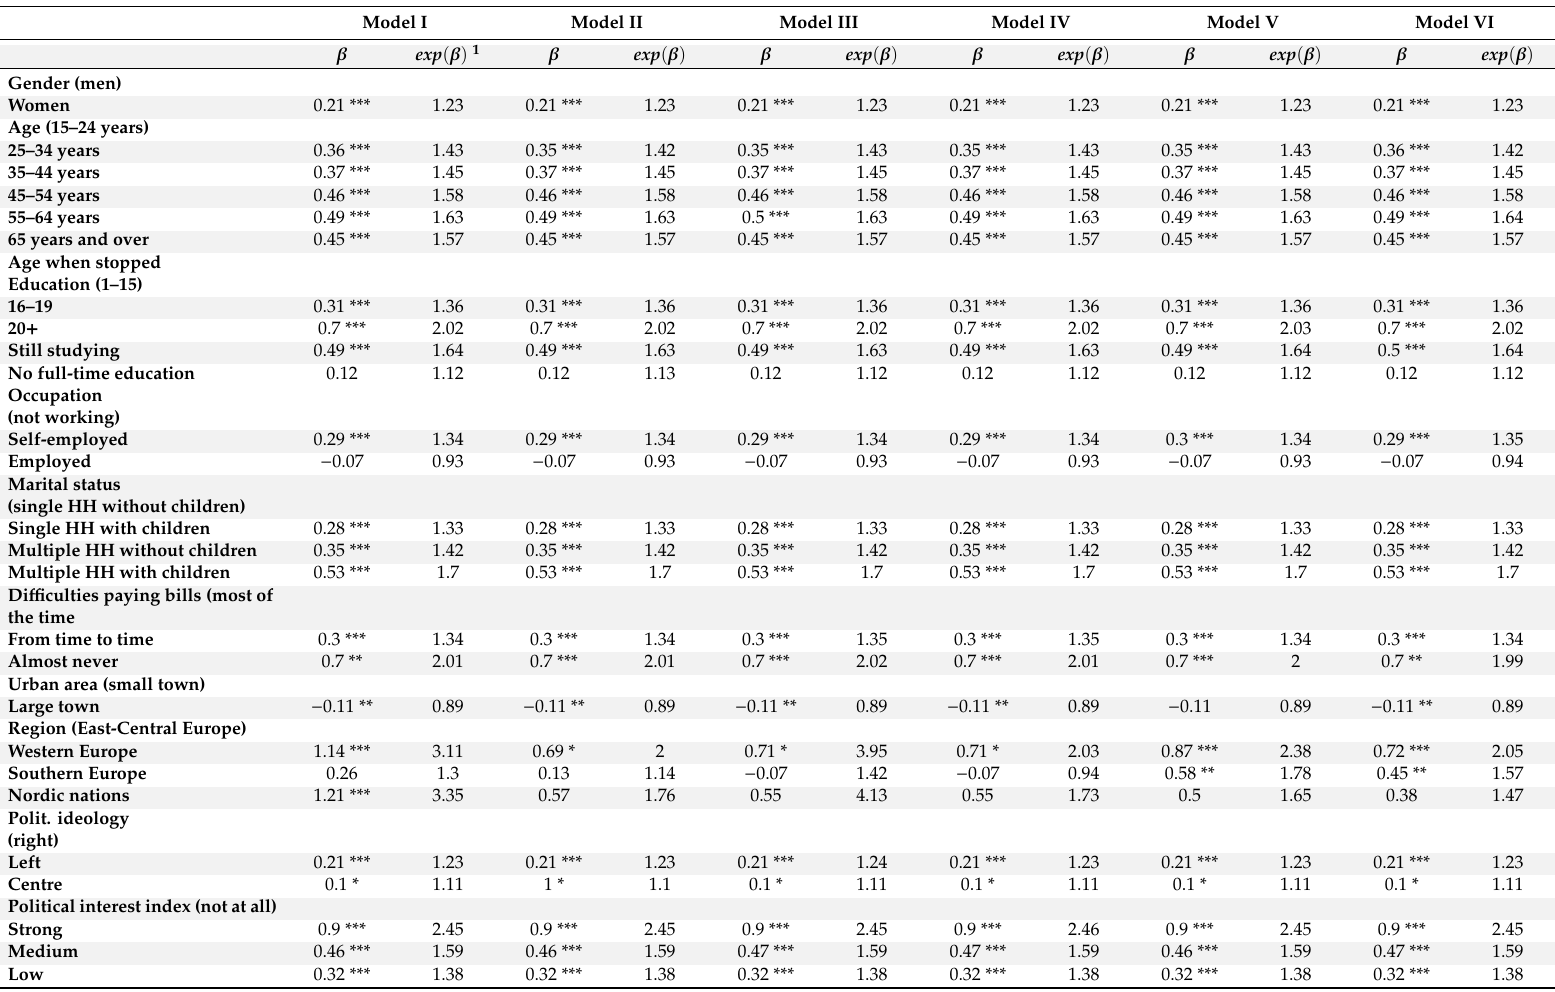
Table A4. Multilevel mixed-e ff ects logistic regression of climate change mitigation cumulative actions in